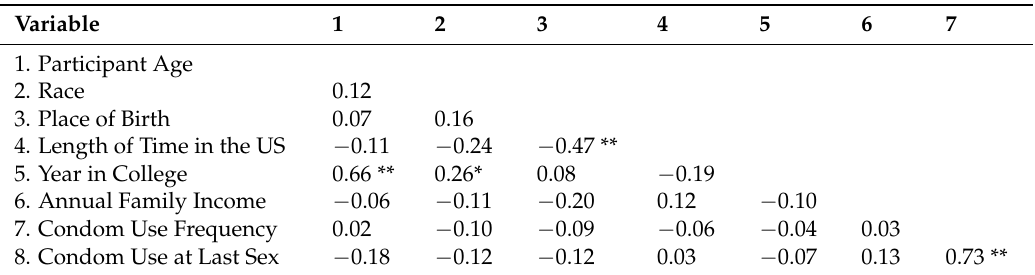
Table 3. Correlations between Demographic Variables and Condom Use (Frequency and at Last Sex). Variable